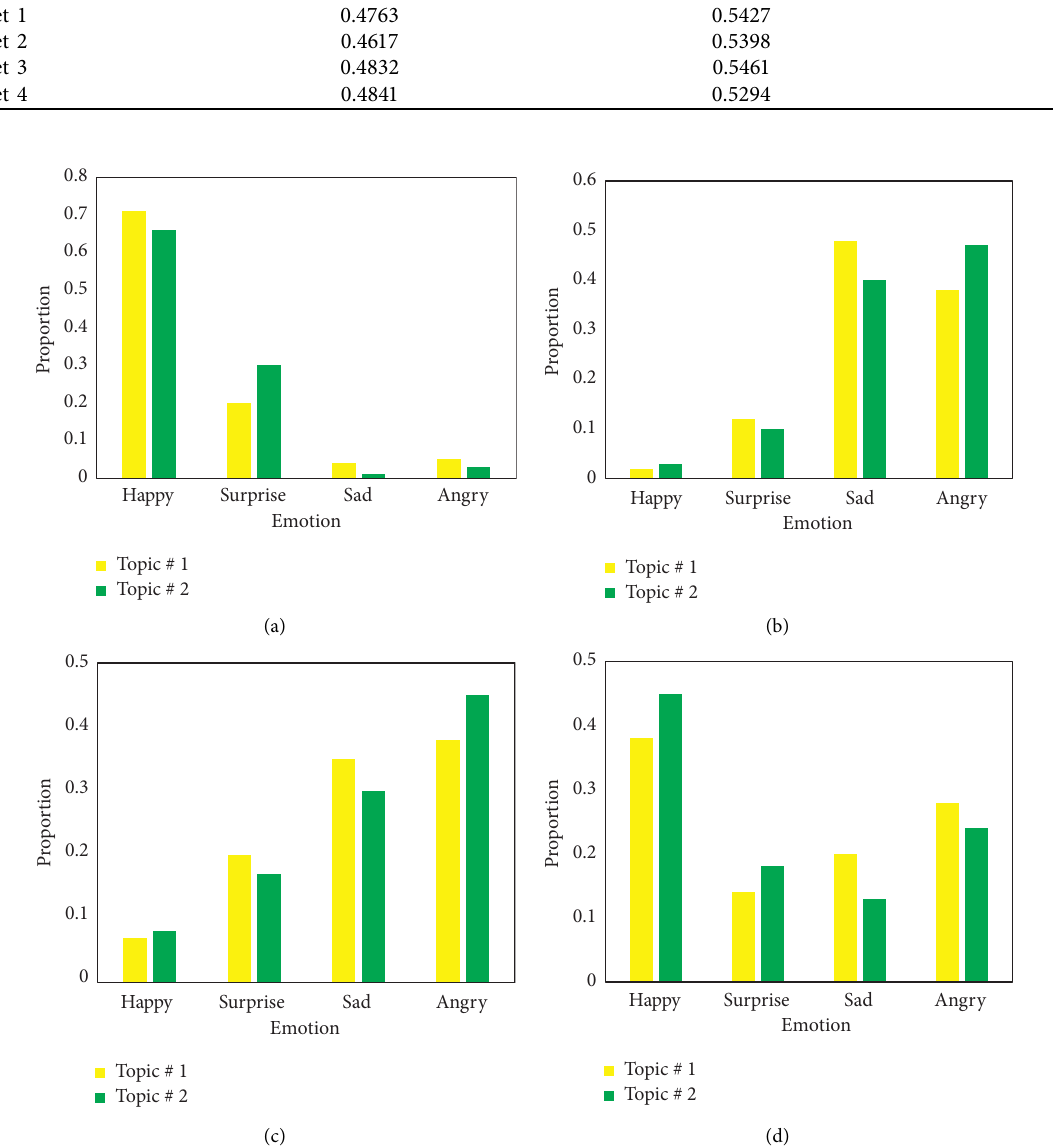
Figure 5: Sentiment distribution in four datasets. (a) Military parade in National Day. (b) The assault on a doctor. (c) Hong Kong’s event. (d) Garbage sorting in